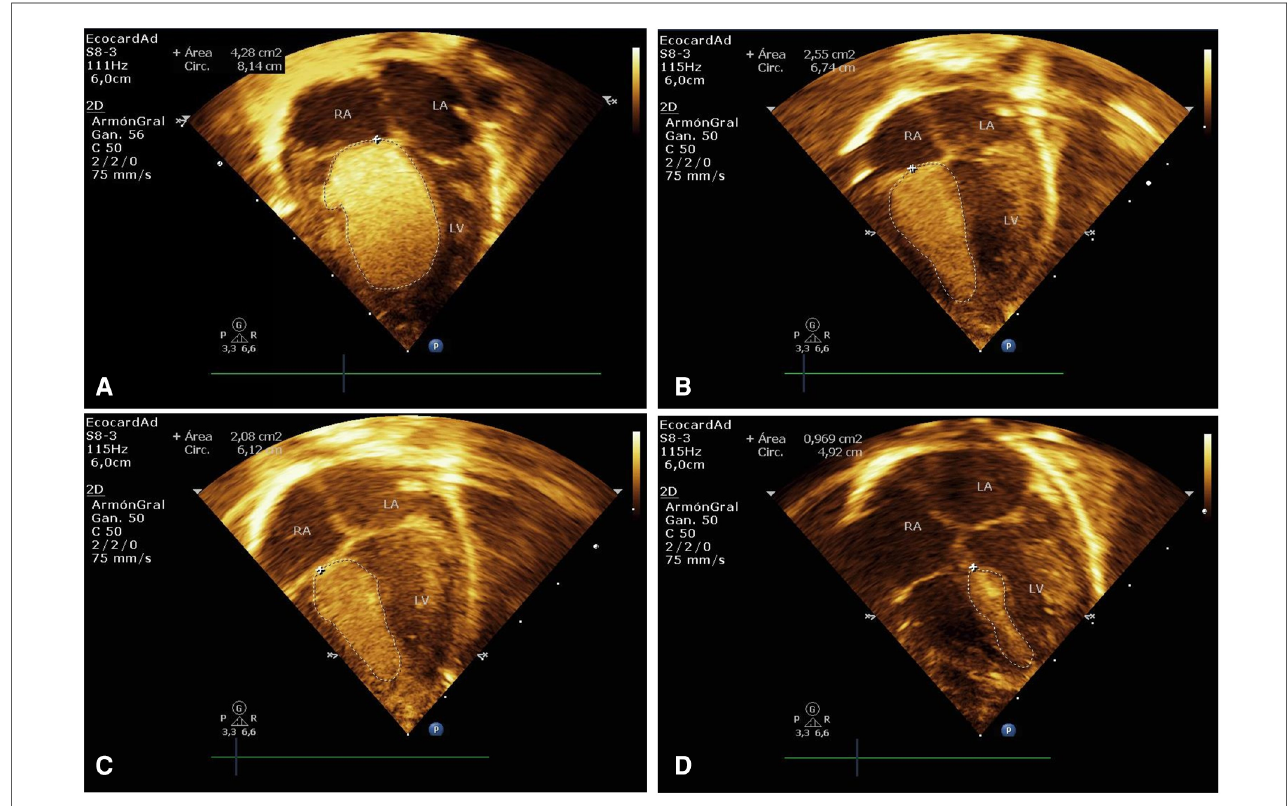
FIGURE 3 Case 2. ( A ) Immediate postnatal transthoracic echocardiogram in apical 4-chamber projection showing a giant rhabdomyoma measuring 30 mm×17.3 mm (area of 4.4 cm 2 ), adhered to the interventricular septum, and occupying a large part of the right ventricular cavity. ( B – D ) Echocardiographic control at 2, 4, and 11 weeks of treatment with everolimus, showed a signi fi cant reduction in the size of the